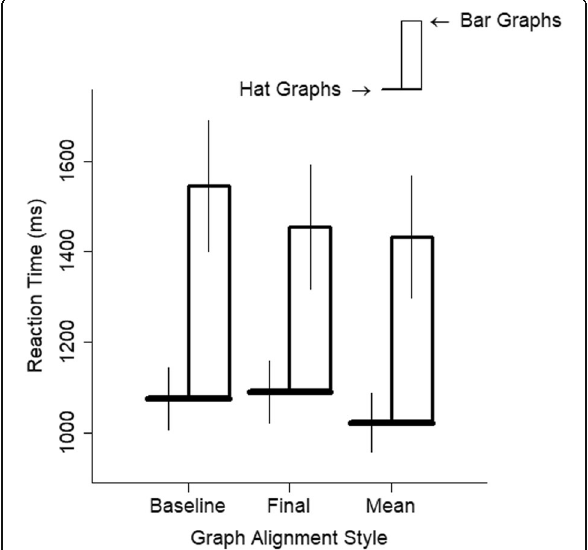
Fig. 9 Reaction time (RT) is plotted as a function of graph alignment style and graph type for experiment 2. The brim of the hat corresponds to the RTs for the hat graph condition, and the top of the crown of the hat corresponds to RTs for the bar graph condition. The size of the crown indicates the difference in RTs between the two conditions. Error bars are ±1 SEM calculated